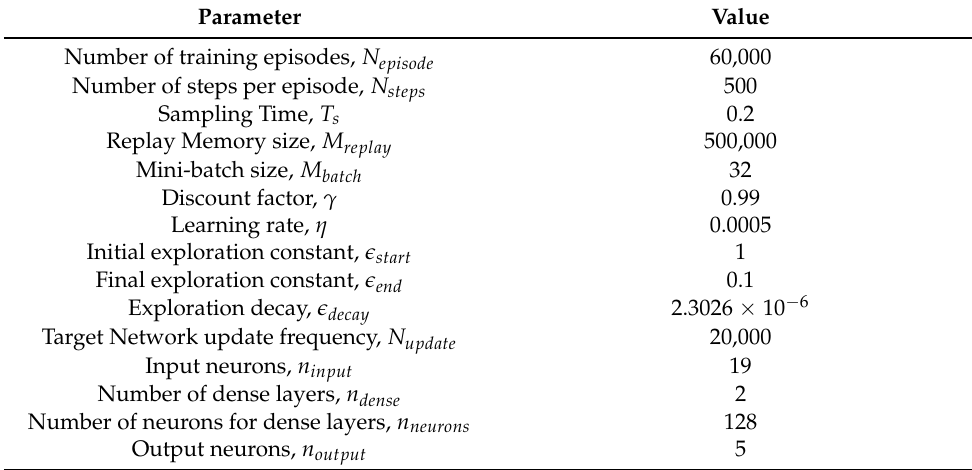
Table 3. Training and DDQN Agent